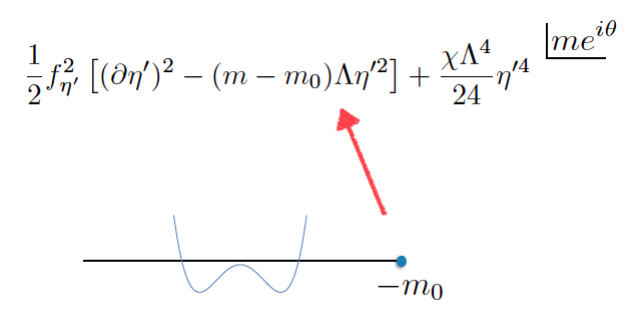
Figure 2 . The phases of QCD with one (cid:13)avor. At me i(cid:18) = (cid:0) m 0 there is a massless (cid:17) 0 particle. Along the real me i(cid:18) axis the theory is time reversal invariant. The (cid:17) 0 (cid:12)eld condenses along that line to the left of (cid:0) m 0 , but not to the right of (cid:0) m 0 . The expression for the e(cid:11)ective Lagrangian is as in the large N limit, expanded around m (cid:25) m 0 and j (cid:17) 0 j (cid:28) 1. For (cid:11) = 2 (cid:25)k=N with integer k this is a gauge transformation and so it is more